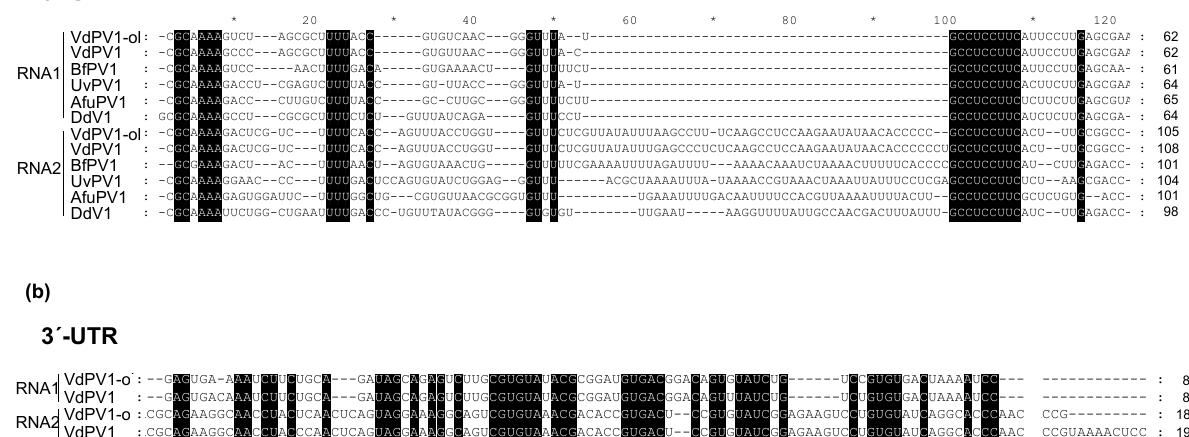
Figure 3. Comparisons of the 5´- and 3´-untranslated regions (UTRs) of the coding regions of RNA1 and RNA2 of VdPV1- ol. (a) Nucleotide sequence alignment of the 5´-UTR of the two genomic segments of VdPV1-ol and VdPV1 and the cor- responding sequences from Botryotinia fuckeliana partitivirus 1 (BfPV1; AM491609.1, AM491610.1), Ustilaginoidea virens partitivirus 1 (UvPV1; KC503898.1, KC503899.1), Aspergillus fumigatus partitivirus 1 (AfPV1; FN376847.3, FN398100.2) and Discula destructiva virus 1 (DdV1; AF316992.1, AF316993.1). (b) Nucleotide sequence alignment of the 3´-UTR of the two genomic segments of VdPV1-ol and VdPV1. Black shading indicates identical the nucleotide composition (Supplementary Figure